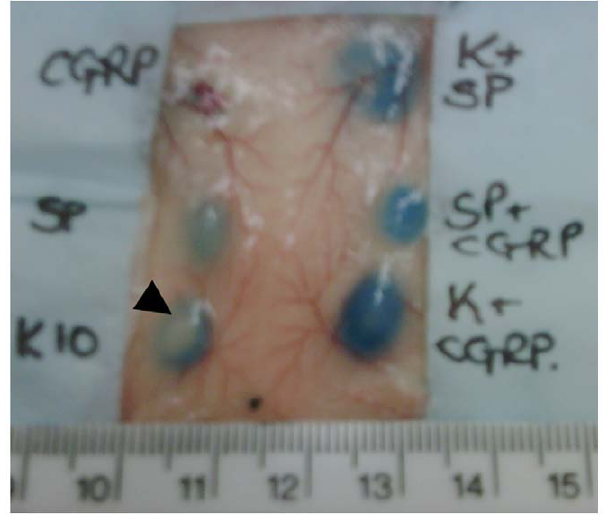
Figure 4. Kisspeptin induced oedema presents with a pallor ring at injection site in the dorsal skin. Female CD1 mice were anaesthetised, injected with Evans Blue i.v. and treated intradermally in the dorsal skin with 10pmol CGRP, 300pmol substance P (SP), 10nmol Kp-10 (K10), 10nmol Kp-10 + 300pmol substance P (K + SP), 300pmol substance P + 10pmol CGRP (SP + CGRP) or 10nmol Kp-10 + 10pmol CGRP (K + CGRP). Plasma extravasation was allowed to continue for 30 minutes. Mice were killed, the dorsal skin removed and photo- graphed. Pallor ring present in Kp-10 mediated oedema, but not under other conditions, is